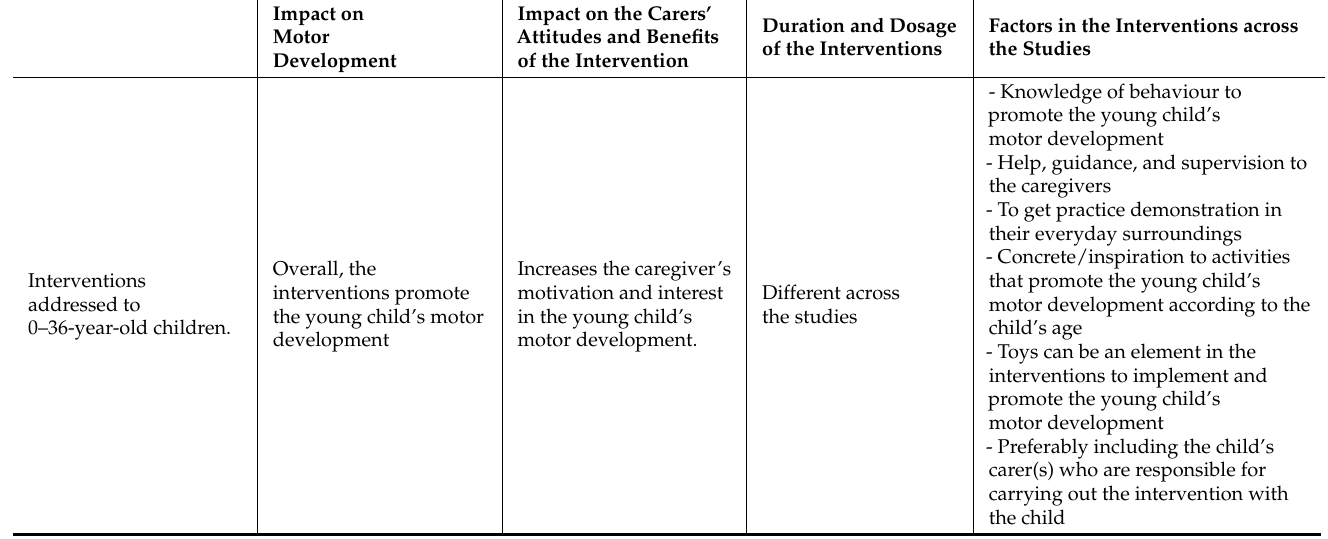
Table 4. General overview of the results according to interventions addressed to 0–36-year-old